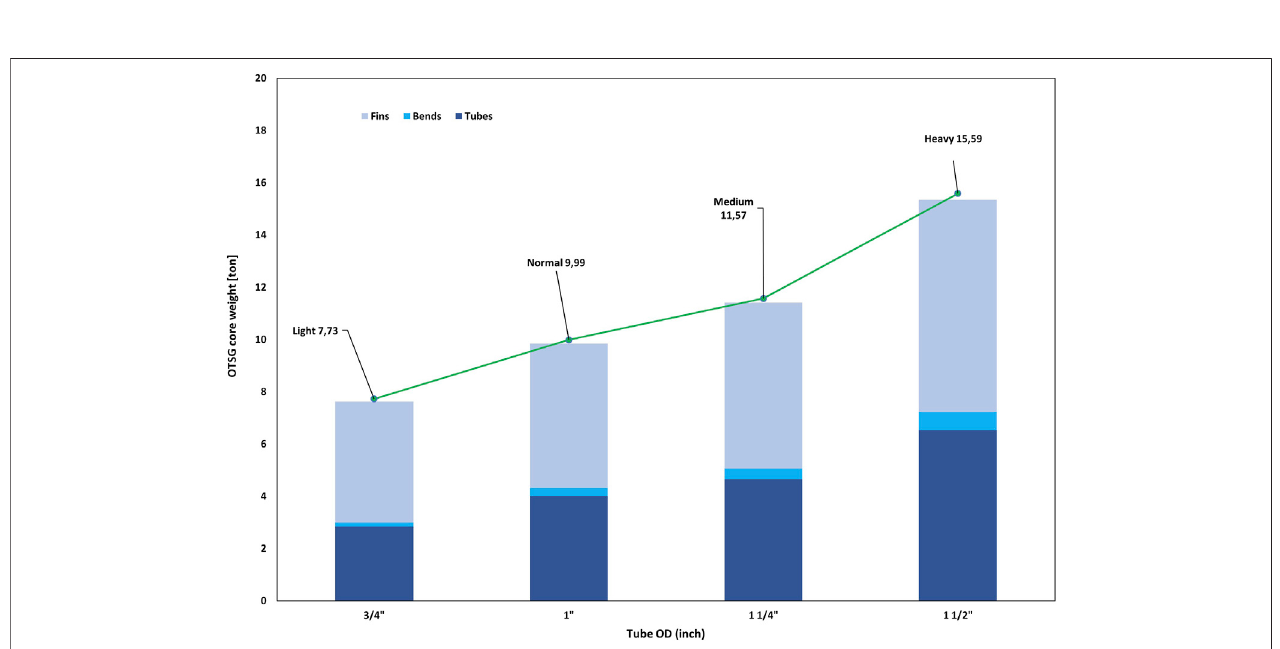
FIGURE 6 | Total OTSG core weight for each OTSG, for boiler tubes OD within the range relevant for off-shore applications as presented in Table 3 .